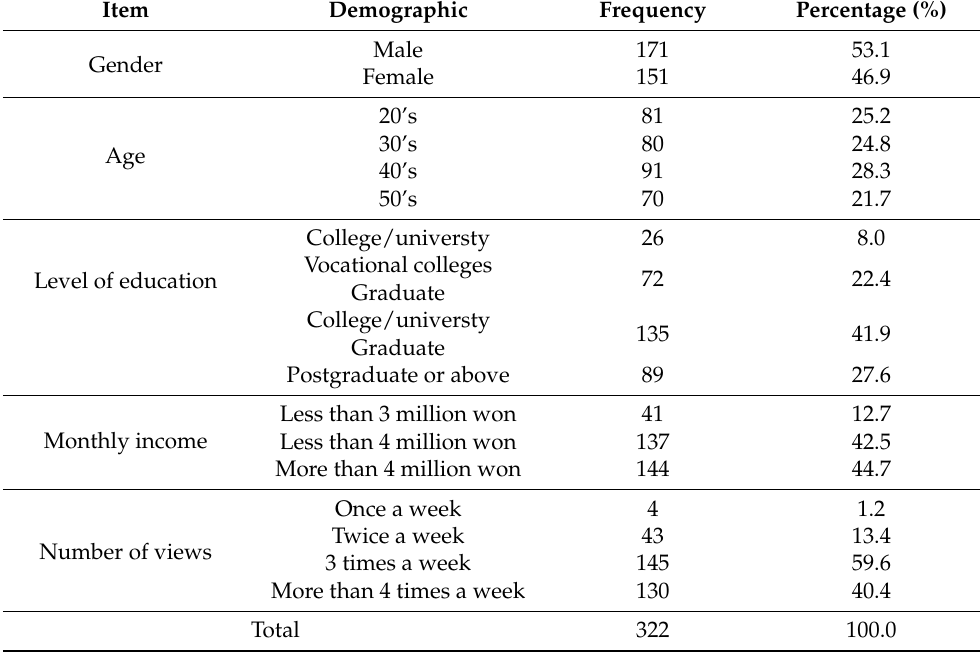
Table 1. Characteristics of study